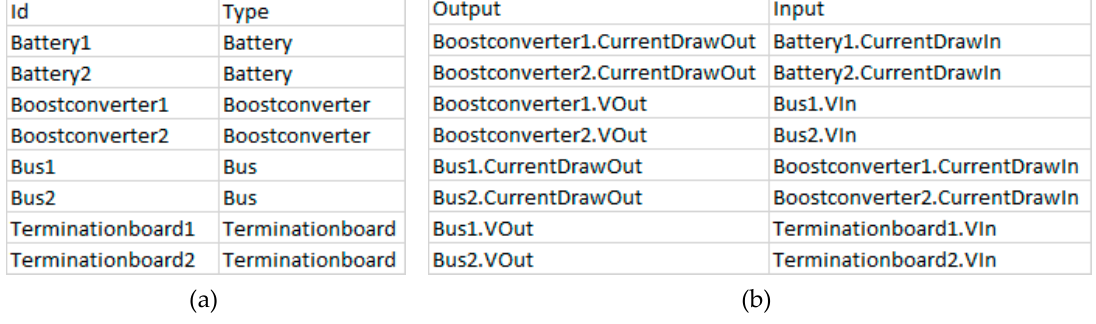
Algorithm 1 of Section 3.2. The two types of connections are necessary to model loops over time.